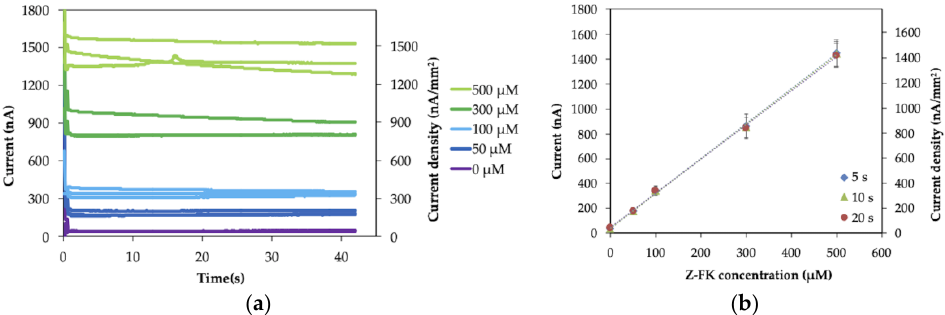
Figure 4. ( a ) Response curve and ( b ) calibration curve of Nα-Carbobenzyloxy-Nε-fructosyllysine (Z-FK) measurement with the IDE enzyme sensor strip in IDE WE — IDE CE mode ( n = 3).